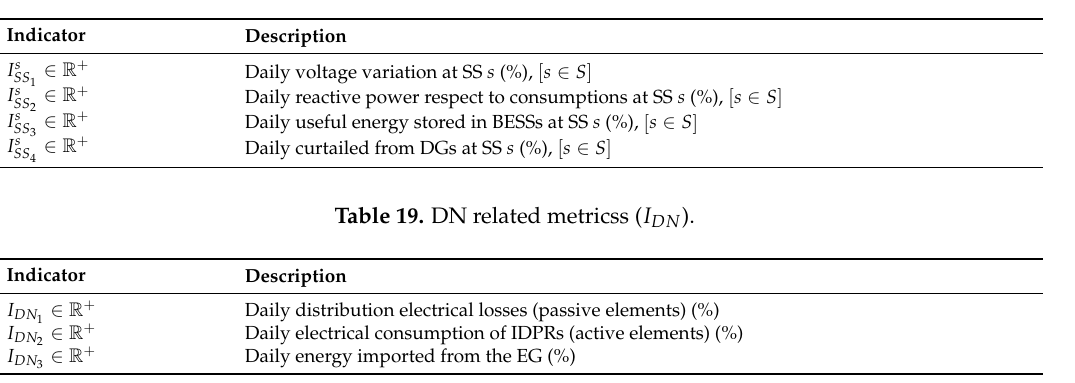
Table 18. SS related metrics ( I SS ).